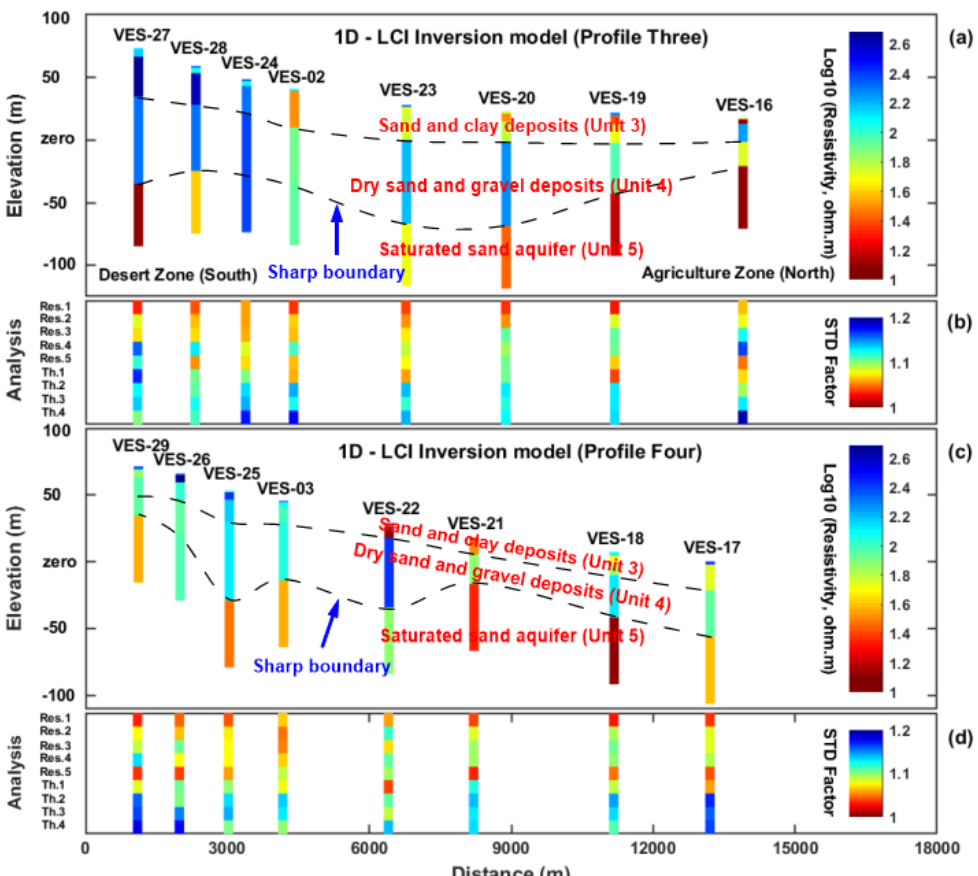
Figure 9. ( a , c ) Inversion result from synchronized 1D–LCI inversion model using five layers, constructed from DC soundings along profile three and four, respectively. ( b , d ) Detailed plot of the resolution analysis of model parameters calculated from final model of 1D–LCI inversion (resistivities; Res.1–Res.5 and thicknesses; Th.1–Th.4) along profiles three and four, respectively. The color-coding of the analysis ranging from red (well resolved parameter, STD factor = 1) to blue (moderately resolved parameter, STD Factor = 1.2).